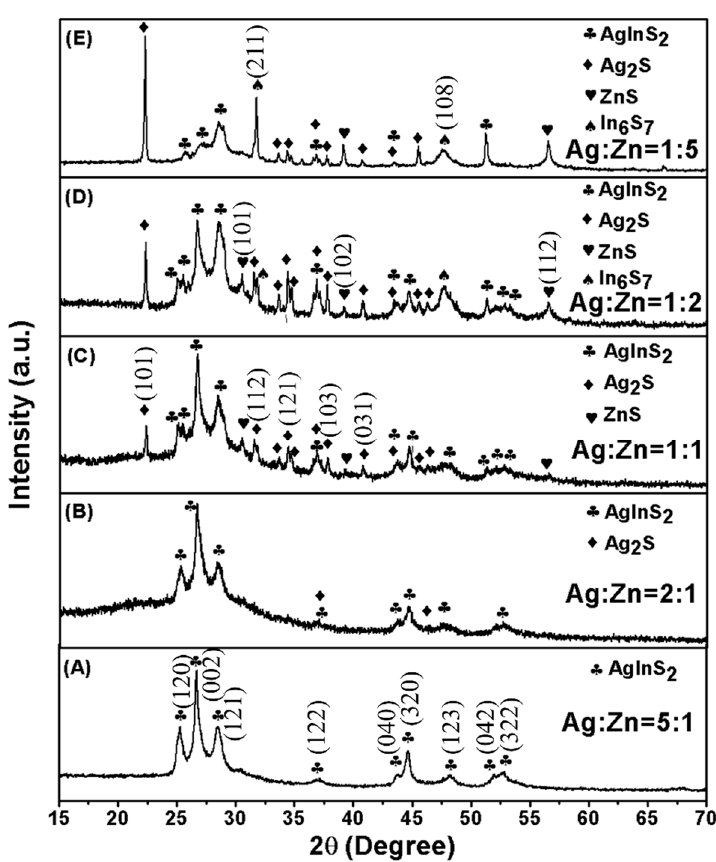
Figure 1. X-ray diffraction patterns of the as-synthesized AgInS 2 - x Ag 2 S- y ZnS- z In 6 S 7 nanojunctions with different molar ratios of Ag to Zn. AgInS 2 : JCPDS 25-1328, Ag 2 S JCPDS 14-0072, ZnS: JCPDS 36-1450, In 6 S 7 : JCPDS 19-0587.